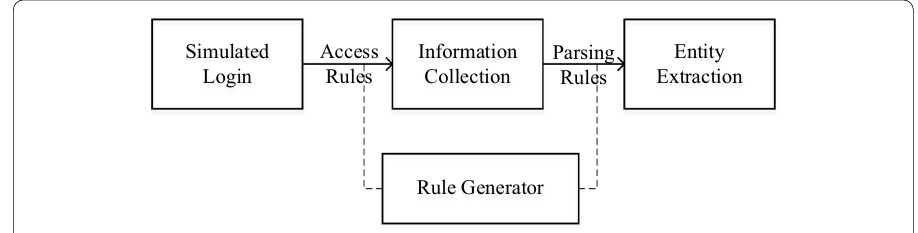
Fig. 5 The process of device